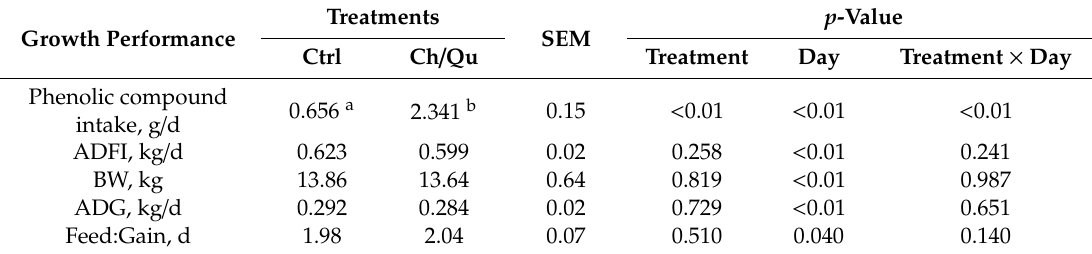
a,b Indicate differences between treatment groups at p < 0.05 within the same day (Trt × Day: p < 0.05). Data are shown as least squares means (LSMEANS) and standard errors of the means (SEM). Ctrl: basal diet; Ch/Qu : basal diet with tannins (1.25%). ADFI: average daily feed intake; BW: body weight; ADG: average daily gain.